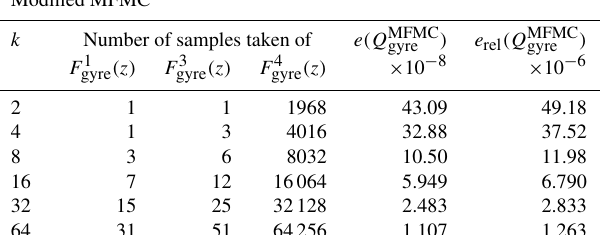
Number of samples taken